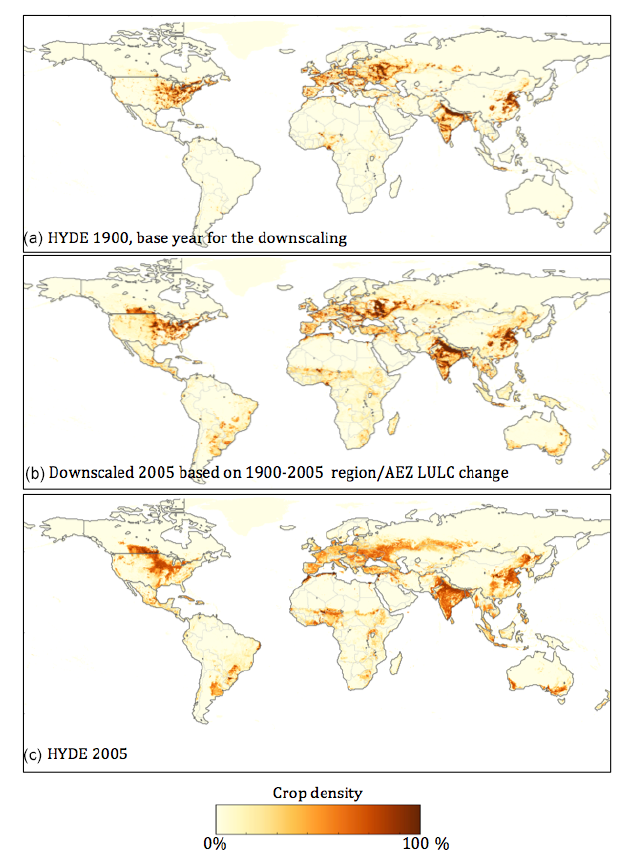
Figure 5. Cropland distribution obtained when downscaling re- gion/AEZ scale land use change from 1900 to 2005 under the basic